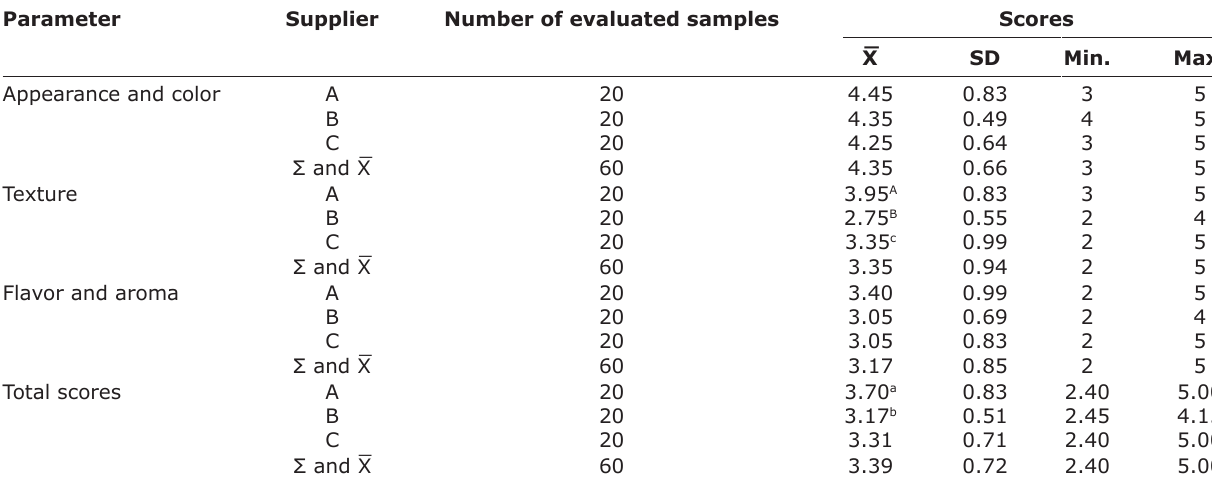
Table-4: Results of the organoleptic evaluation of curd cheeses.